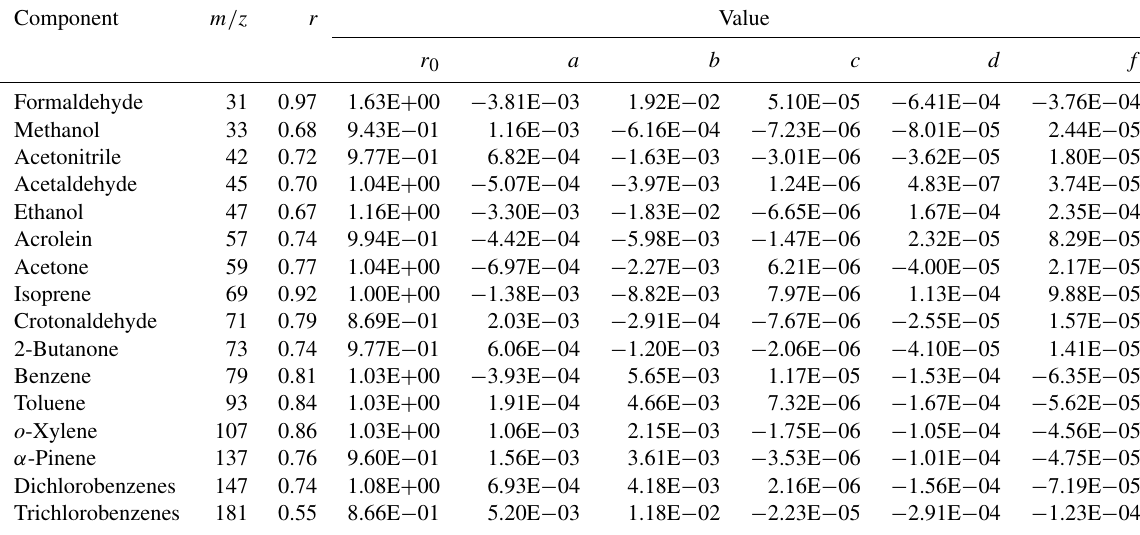
Table 3. Poly 2-D simulation results of different species in gas standard for the